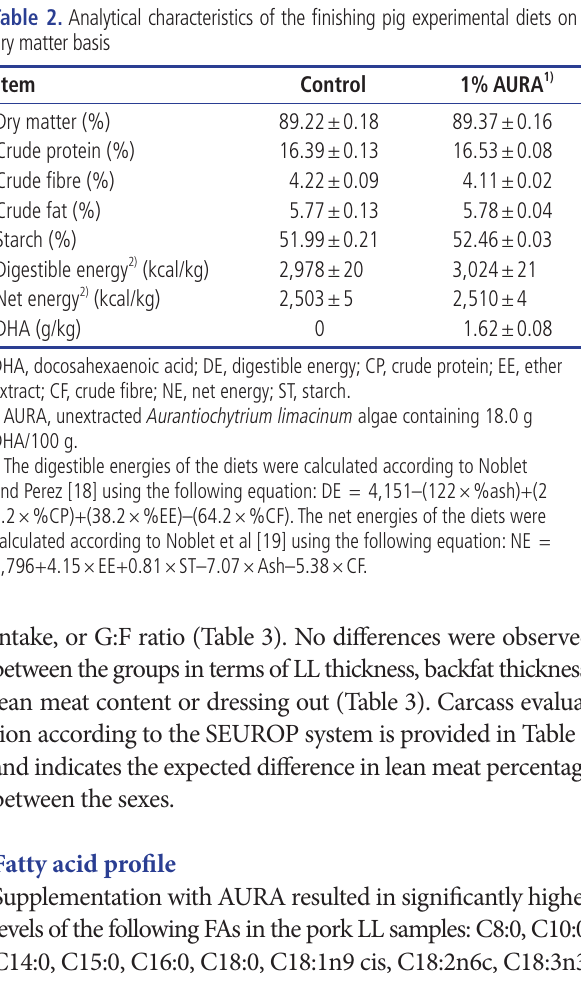
Table 4. Effect of supplementation of a finisher pig diet for 31 days with